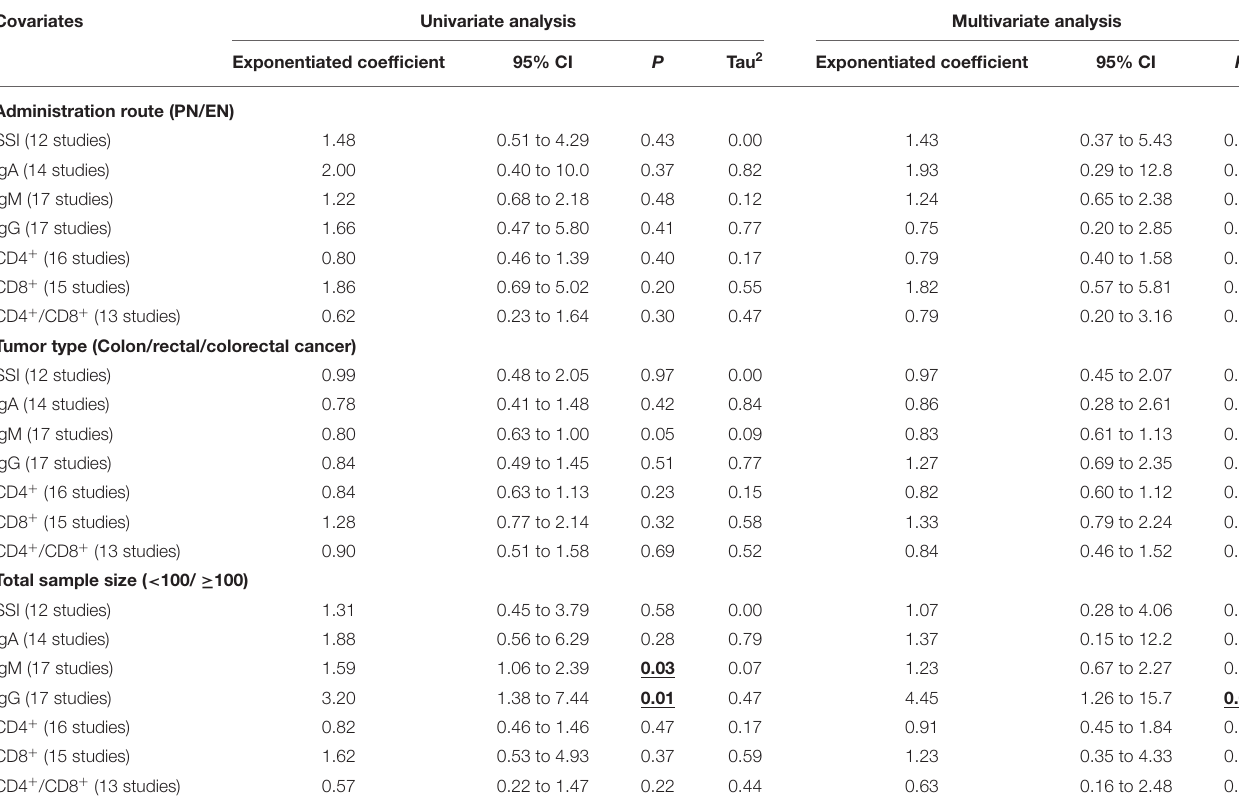
TABLE 2 | Results of Meta-regression analysis. Covariates